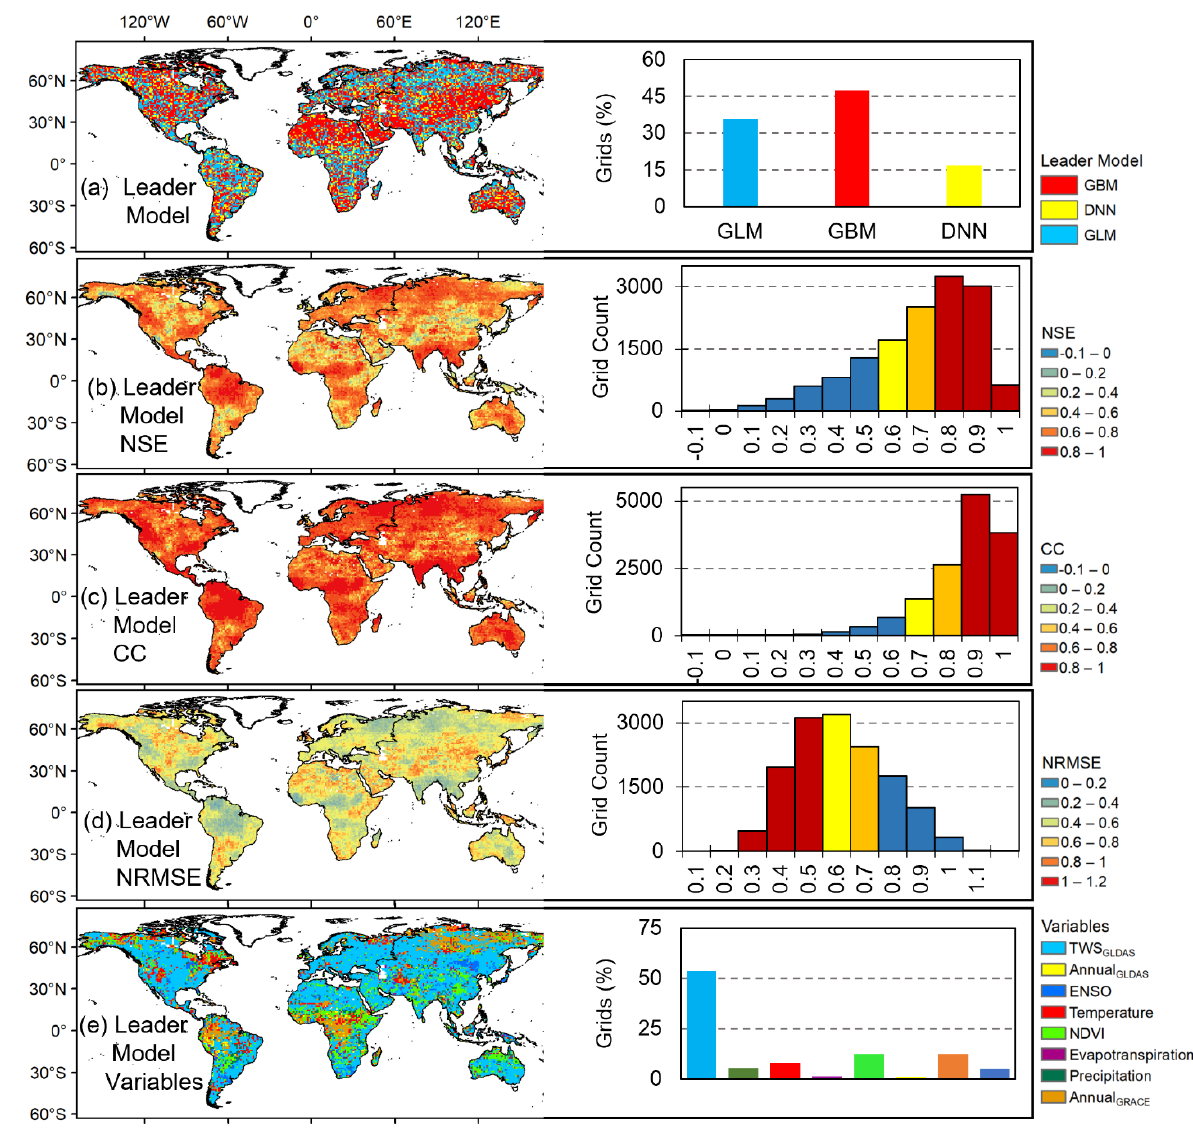
Figure 5. Spatial (left) and frequency (right) distribution of the grid-scale variable importance for ( a ) GLMs, ( b ) GBM models, and ( c ) DNN models. Because model performance varies by grid location (Figure 3), a leader model (e.g., testing results (Figure 6a). The GBM model was the leader for 47% of the examined grid